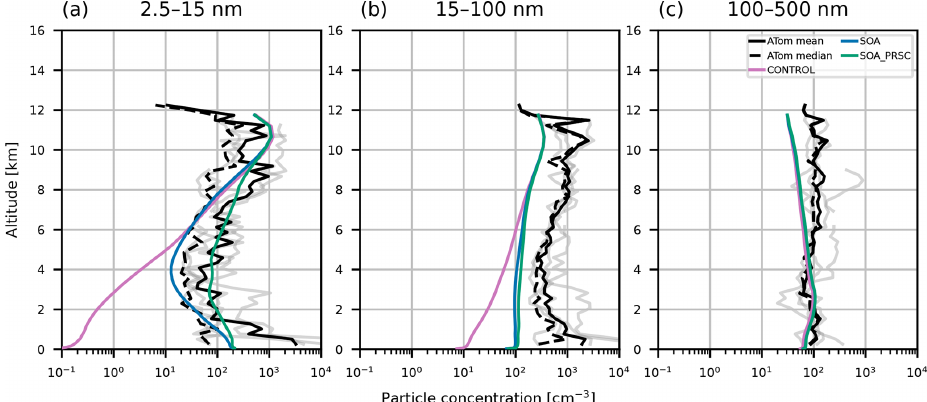
Figure 6. Aerosol vertical profiles from model output and ATom campaign observations from 2016. Model output is from collocated 2018 monthly mean values from simulations CONTROL (pink), SOA (blue lines), and SOA_PRSC (green lines). ATom observations are taken from leg 1 of the campaign and restricted to measurements that were taken north of 60 ◦ N. Observations correspond to mean profiles from different days (grey lines), the overall mean (solid black lines), and overall median (dashed black lines). Profiles are for particles with size (a) 5–10nm, (b) 10–100nm, and (c) 100–500nm. Observations were recorded at standard temperature and pressure; the model output has been adjusted to account for